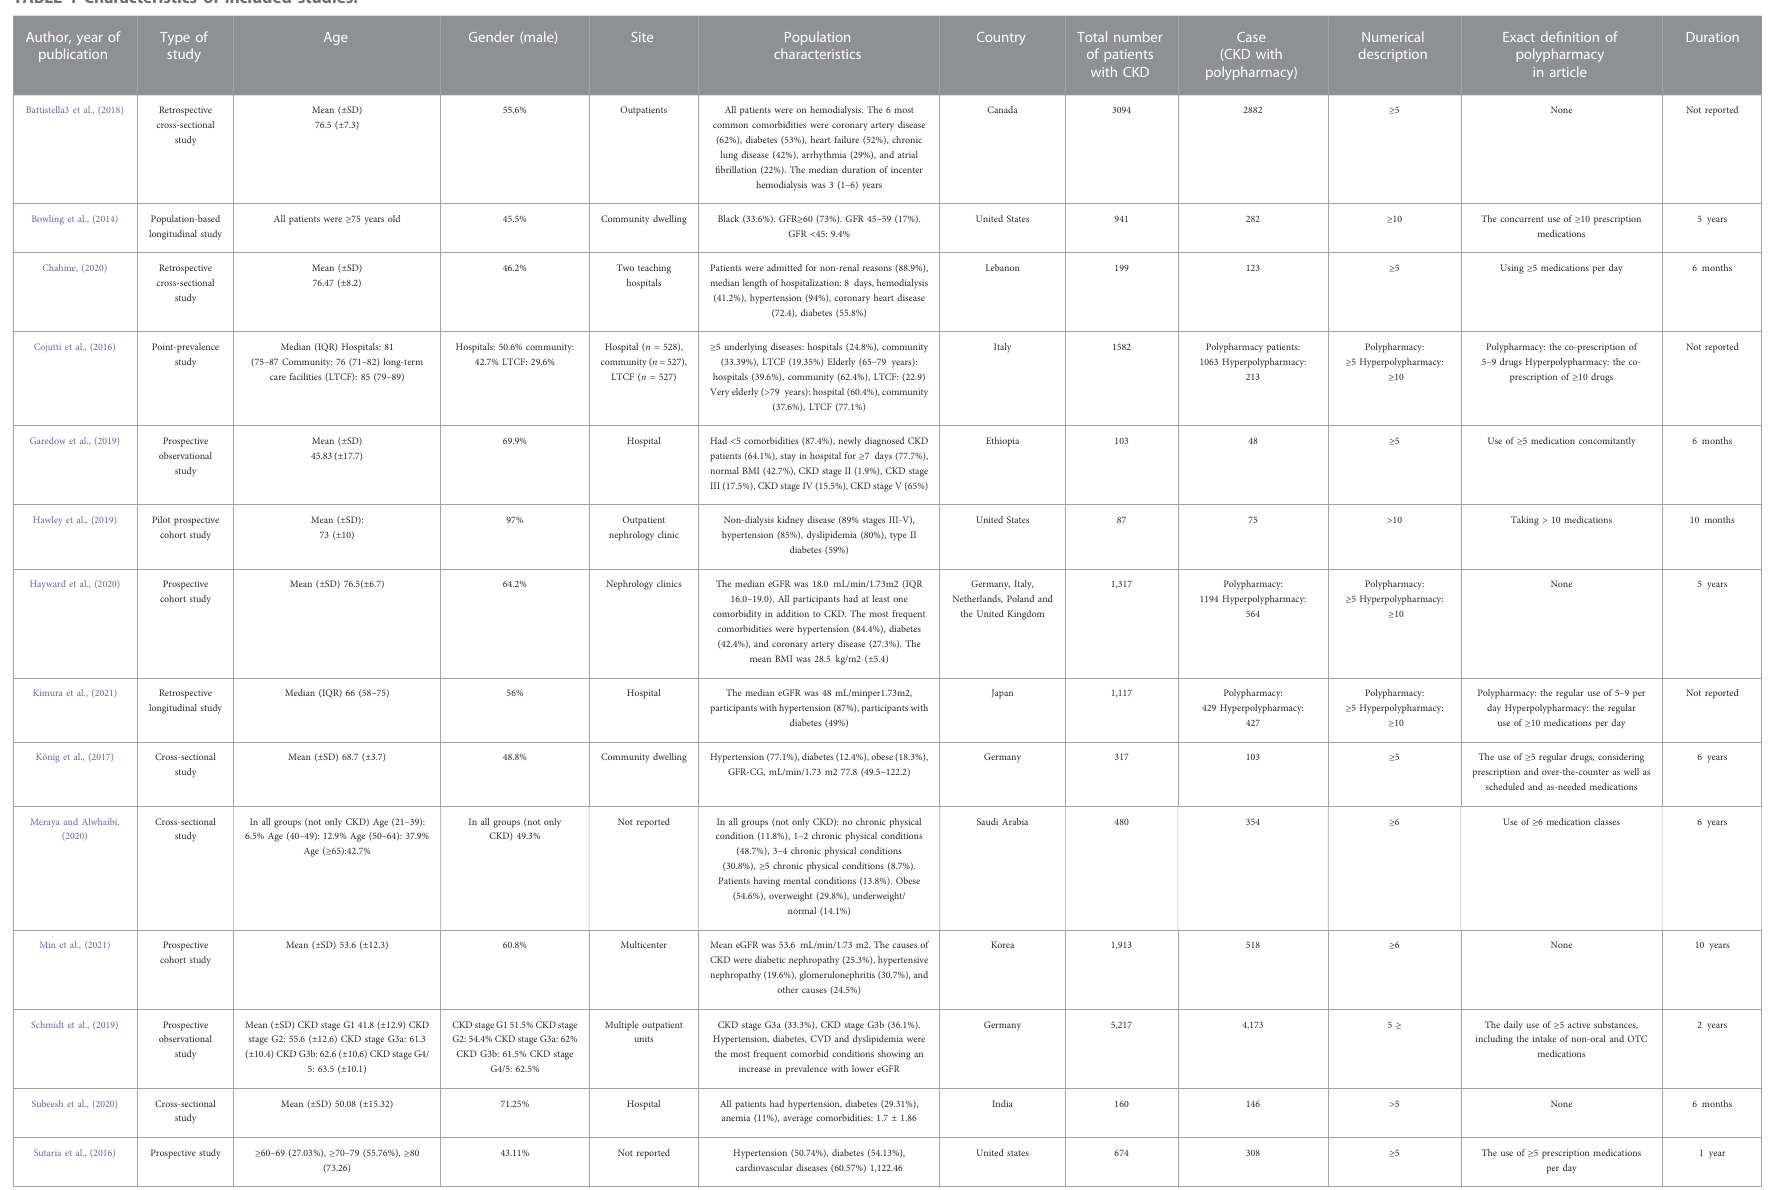
TABLE 1 Characteristics of included